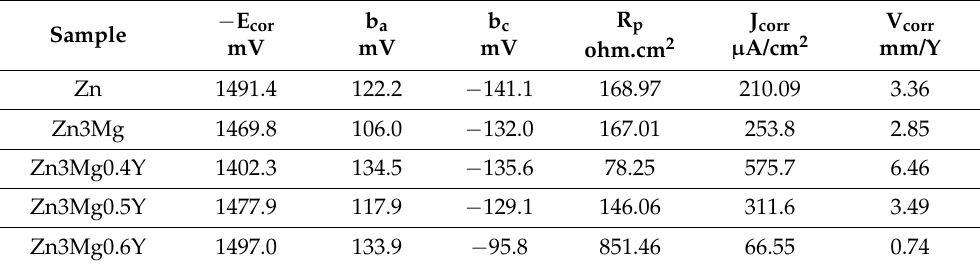
Figure 7. Microhardness experiments pure Zn and Zn-alloy behavior.